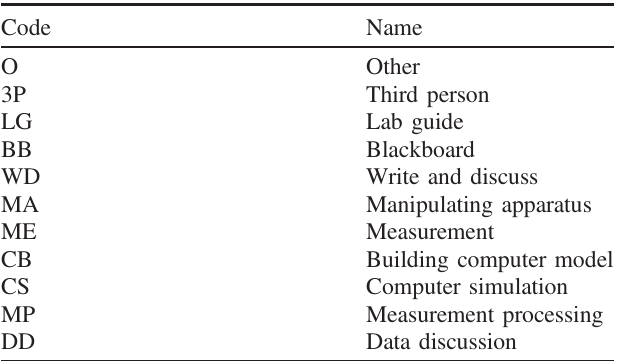
TABLE II. Categories for contexts. These are explained in more depth in Table V in the Appendix.